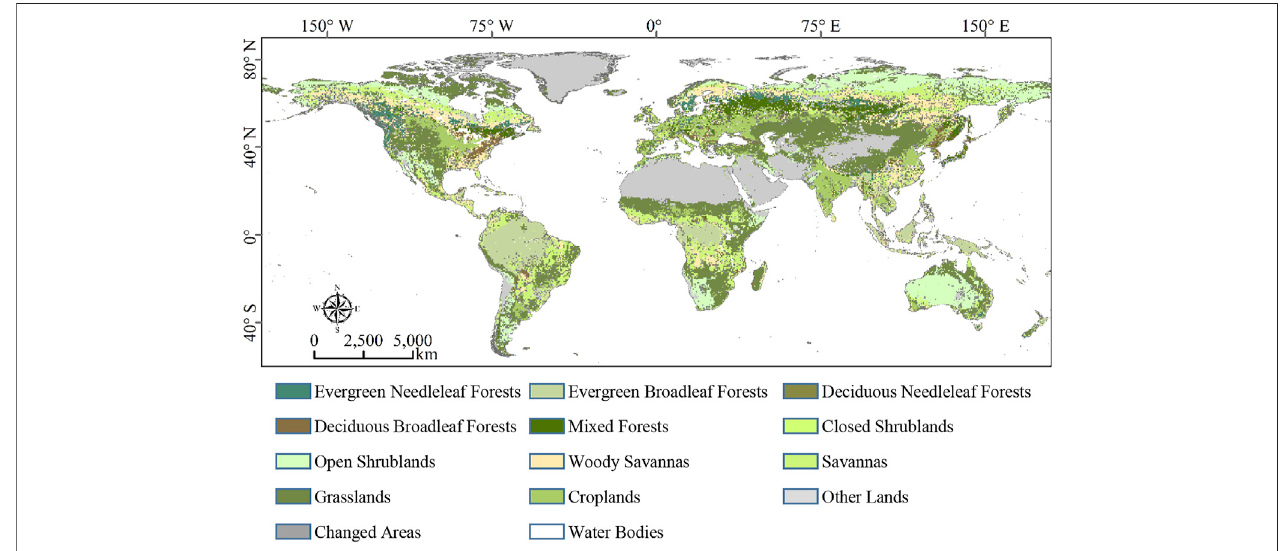
FIGURE 1 | Spatial distribution of unchanged IGBP land cover types obtained from MCD12C1 Version six during the study period.